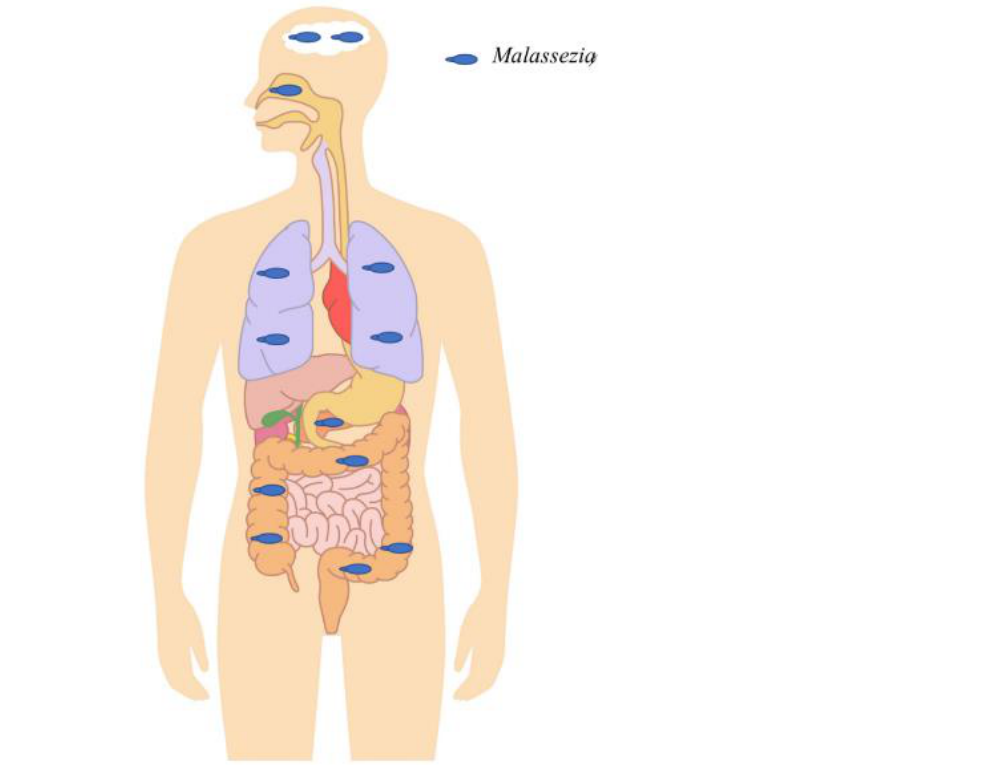
Figure 2. Malassezia in different anatomical sites detected in the context of chronic diseases or healthy individuals outside the skin. Malassezia was abundantly detected in the digestive tract and was shown to be associated with Crohn’s disease by exacerbating colitis and infl ammation. Further- more, it was highly abundant in colorectal cancer patients compared to healthy subjects, suggesting a potential role in tumorigenesis. It was also shown to be able to migrate from the gastrointestinal tract lumen to the pancreas and to exacerbate pancreatic adenocarcinoma progression. High abun- dance was also found in the gastrointestinal tracts of HIV patients, probably due to HIV-related immunosuppression. It was highly detected in the upper and lower respiratory tract. Within the upper respiratory tract, it has been shown to interact with specific bacteria ( Pseudomonas aeruginosa and Staphylococcus aureus ) and to increase chronic rhinosinusitis-associated inflammation. Within the lower respiratory tract, it was shown to be associated with cystic fibrosis pulmonary exacerba- tions. Finally, Malassezia were detected with a relatively high prevalence and abundance in brain tissue samples of patients with neurodegenerative diseases, such as Alzheimer’s disease, Parkin- son’s disease,